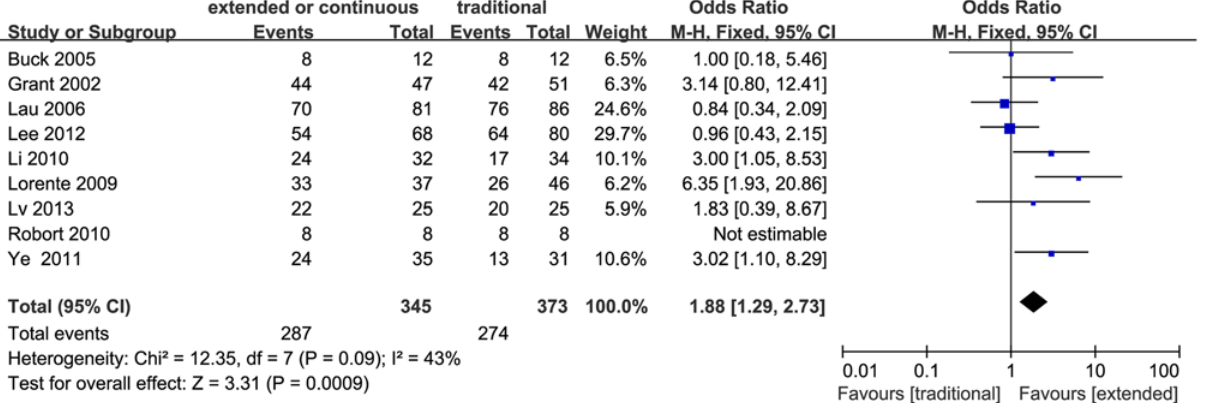
Figure 2. Forest plot depicting the odds ratios of clinical cure of patients receiving extended or continuous versus conventional intermittent infusion of